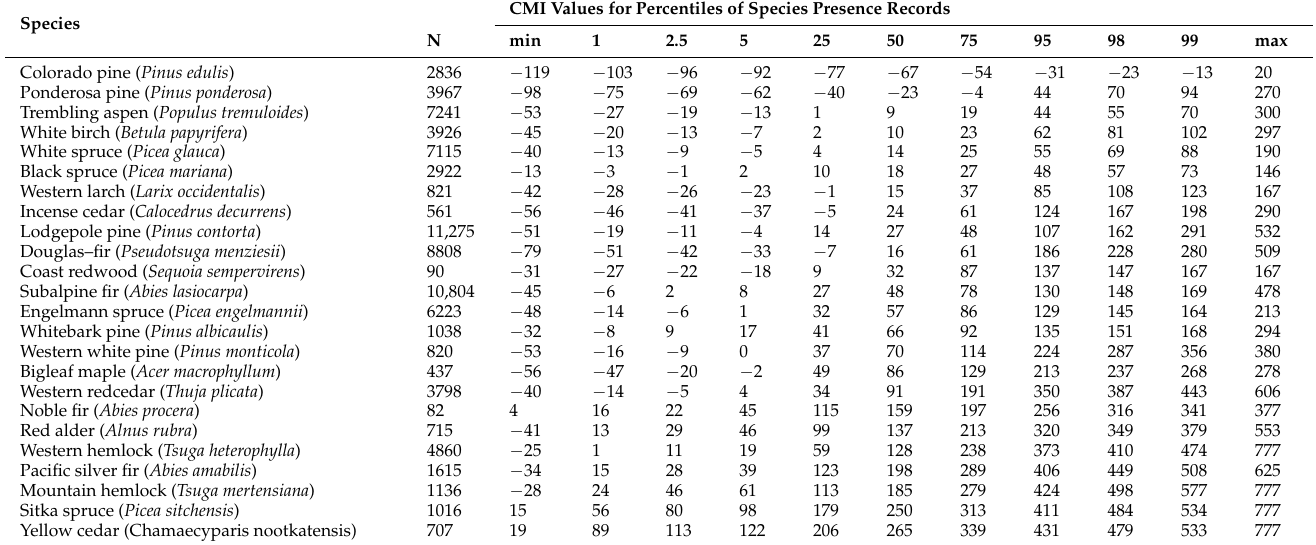
where species distribution limits occur along the rain shadows of the Coast Mountains, where the conditions become too dry. About half of the 24 species that were evaluated had 5% or more populations that were located in areas with negative CMI values, which are therefore potentially vulnerable to drought conditions (Table 1). Five species had 25% of their populations exposed to dry habitat, indicated by the CMI values below zero, and for two species, the Colorado pine and the ponderosa pine, half of the occurrence records were located within areas with negative CMI values. Table 1. Climate moisture index values for the percentile of plot locations where each species occurs. We use the 2.5th percentile CMI value as a putative species drought tolerance metric for the purpose of subsequent analysis, although this should not be interpreted as a general species drought tolerance limit, as other climatic and non-climatic factors may limit species range. N denotes the number of presence records evaluated for each